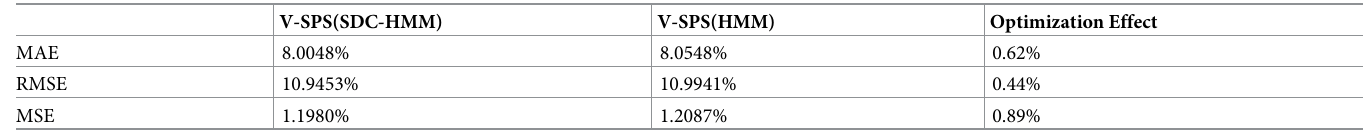
Table 3. The results of the SDC-HMM on Fitness-GDP forecast